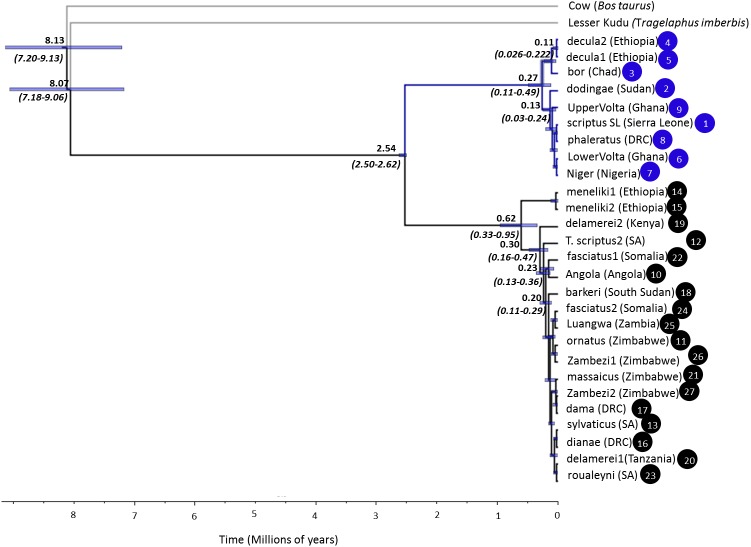
Multilocus Bayesian phylogeny of 27 bushbuck (Scriptus and Sylvaticus) individuals at four nuclear introns (MGF, PRKCI, SPTBN, and THY) reconstructed in BEAST.Median divergence time estimates (in MYA) are given for nodes appearing in more than 50% of the post-burn in posterior distribution. Nodal 95% HPD values are adjacent to their respective nodes and shown graphically by purple nodal bars. The two bushbuck lineages Scriptus and Sylvaticus are colored as in Fig. 1.